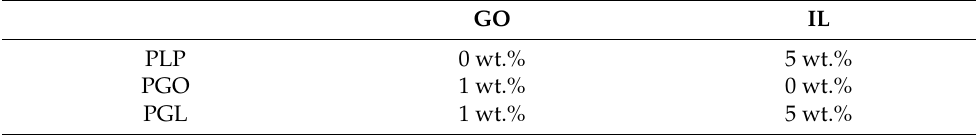
Table 2. Concentrations of additives in the PLA-based compounds.